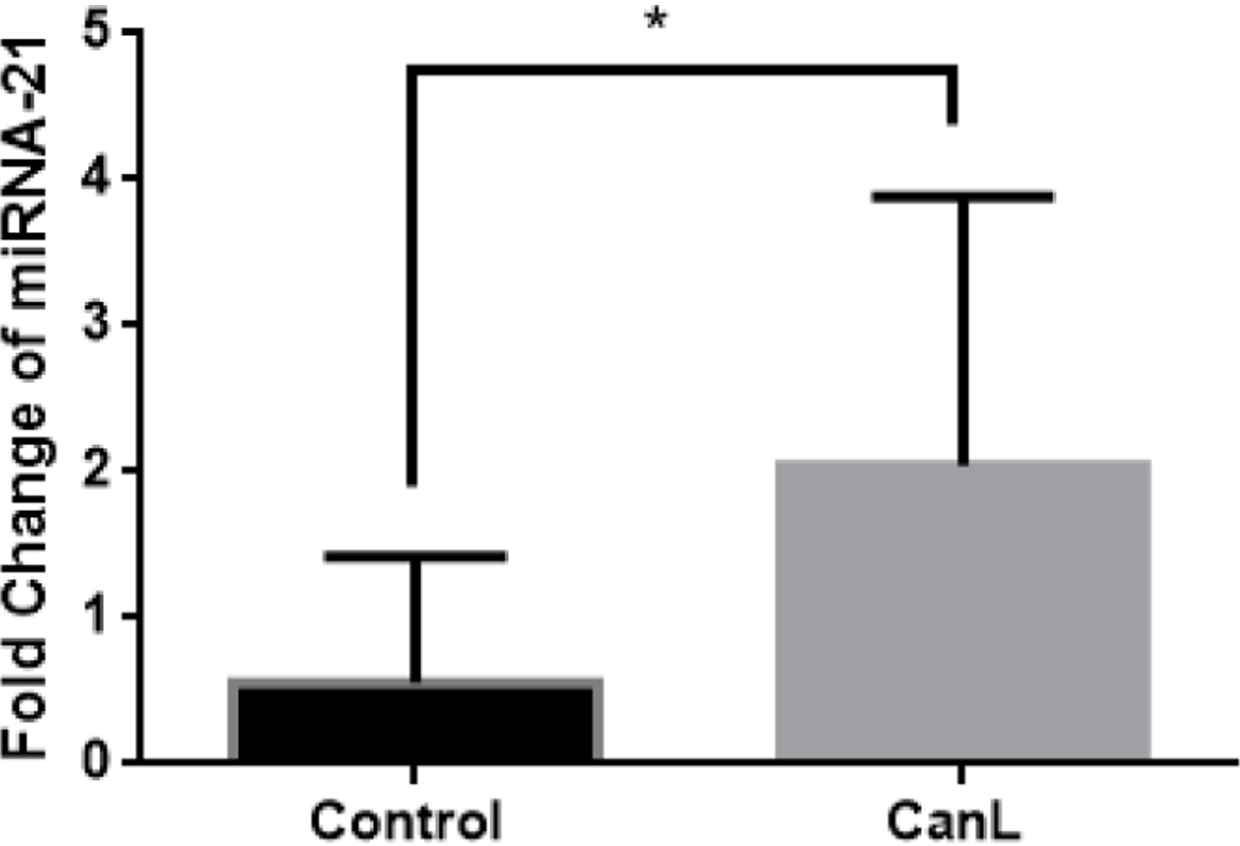
Fig 1. Expression of miR-21. miR-21 expression using real-time PCR. Expression of miR-21 was quantified using real-time PCR in splenic leukocytes of CanL (n = 10) and control (n = 5) dogs. Fold change of miR-21 was calculated with normalized results by converting the sample cycle threshold values to a concentration (ng/ μ l). Data represent the mean values of miRNA expression ± standard deviation, and the asterisks represent statistically significant data following the Mann–Whitney test. Results were considered significant when p < 0.05.